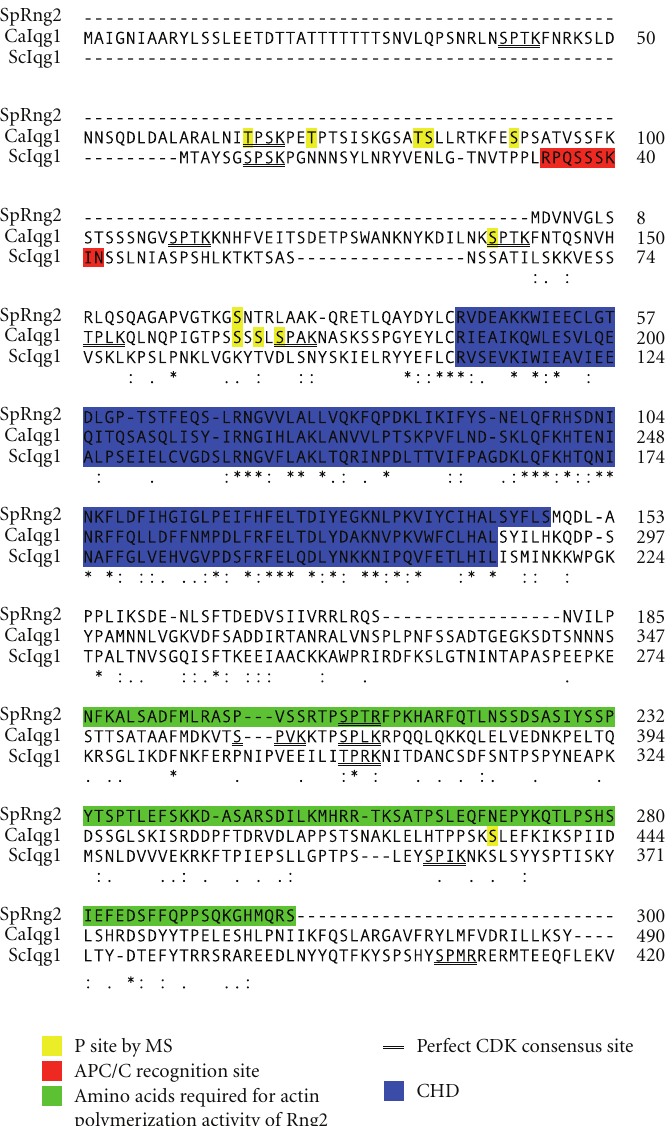
Figure 2: Amino acid sequence alignment of the N-terminus from S. pombe (SpRng2), C. albicans (CaIqg1) and S. cerevisiae (ScIqg1). Amino acids 1–300 of Rng2, which were identified as important for F-actin nucleation activity of Rng2 in vitro , were aligned with the N-terminal 490 amino acids of CaIqg1 and 420 amino acids of ScIqg1 using Clustal 2.1 multiple sequence alignment default settings at http://www.ebi.ac.uk/Tools/msa/clustalw2/. Amino acids highlighted in yellow were identified as phosphorylation sites by mass spec analysis, doubly underlined amino acids represent consensus CDK sites (S/TPxK), amino acids highlighted blue are the CHD, ScIqg1 amino acids highlighted in red are the APC/C recognition site, and Rng2 amino acids highlighted green are those identified as being important for F-actin nucleation